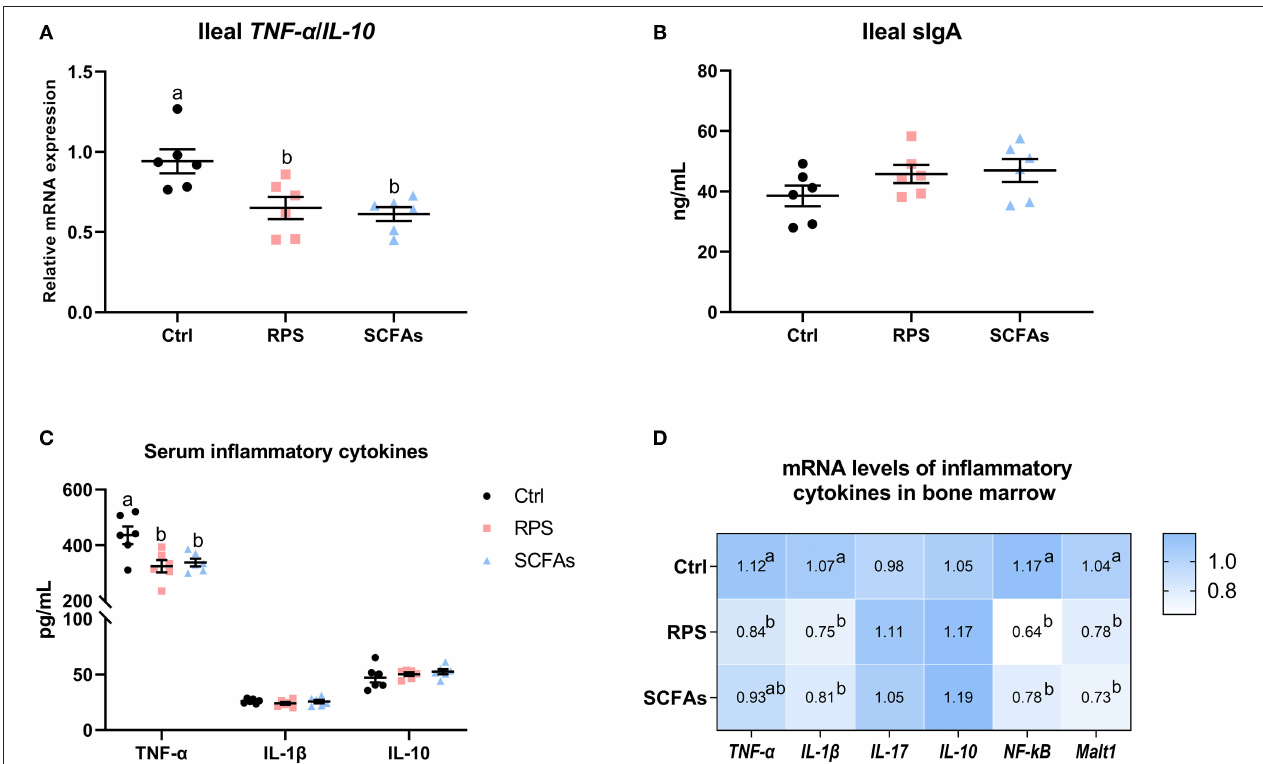
FIGURE 6 | Dietary RPS and drinking SCFAs are associated with alleviative inflammatory reactions. (A) The ratio of tumor necrosis factor alpha ( TNF- α ) and interleukin ( IL )- 10 , and (B) the content of secretory immunoglobulin A (IgA) in the ileum. (C) The levels of TNF- α , IL-1 β , and IL-10 in serum from different groups. (D) The mRNA expression of inflammatory cytokines in bone marrow including TNF- α , IL-1 β , IL-17 , IL-10 , nuclear factor- κ B ( NF- κ B ), and mucosa-associated lymphoid tissue lymphoma translocation protein 1 ( Malt1 ). Data are expressed as mean and standard deviation. a,b Mean values with different letters are significantly different by one-way analysis of variance followed by Tukey’s post-hoc test ( p <